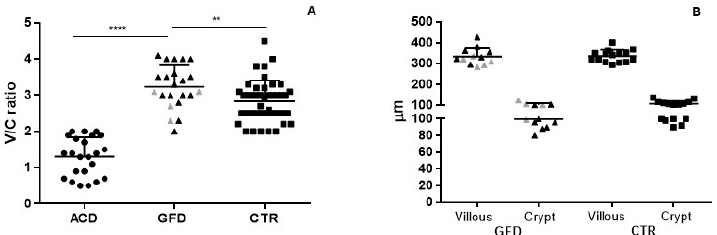
Figure 1. ( A ) Villous/crypts ratio in patients with villous atrophy, on a gluten free diet and in control patients. ( B ) Villi and crypts length in patients on a gluten free diet and in control patients. Grey dots represent patients on a gluten free diet with a persistently positive CD-serology. V/C: villous/crypts ratio; ACD: atrophic celiac disease; GFD: gluten free diet; CTR: controls. *: level of statistical significance; ** means p < 0.005, **** means p < 0.00005.